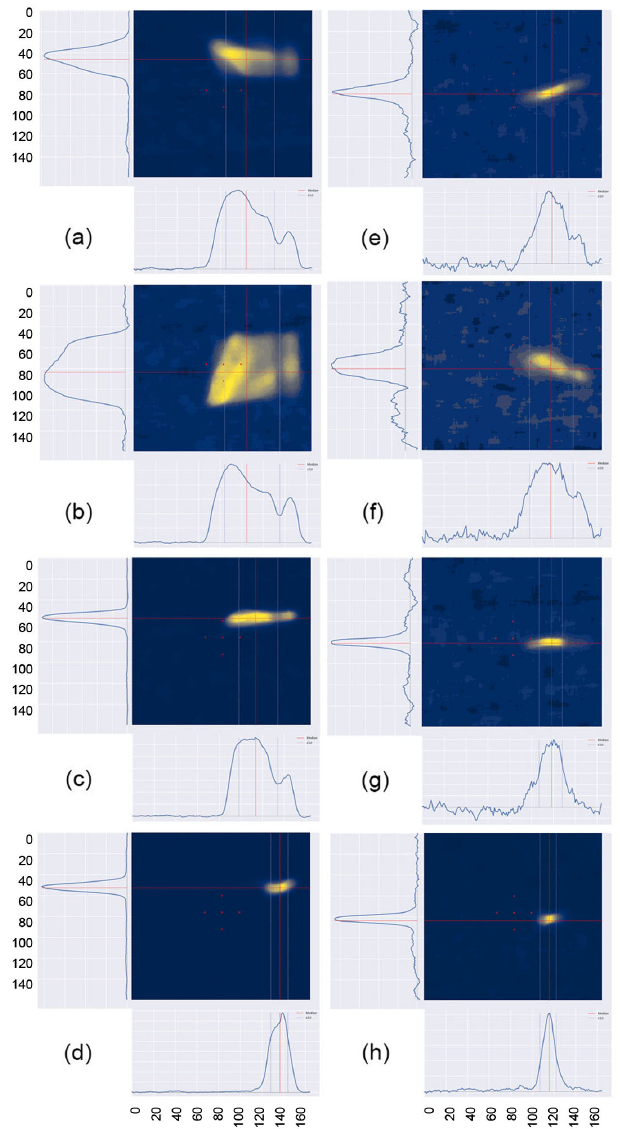
FIG. 4. BeamspotseenatFP1before(a – d)andafter(e – h)steerers optimization with a Ne beam. Beam movement due to unbalanced quadrupole forces decreased from an average of 7 mm to an average of 0.2 mm. All axes are in pixels, and 16 pixels correspond to 5 mm.